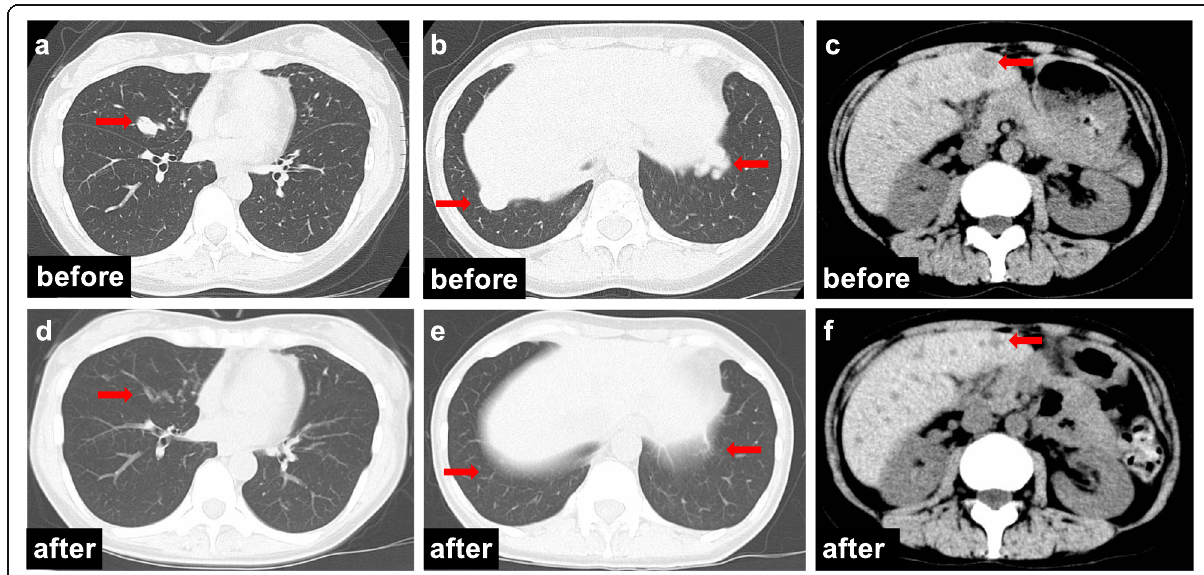
Fig. 4 Whole-body CT before and after chemotherapy. Lung metastatic nodules ( a , b ) and liver tumors ( c ) were detected. According to treatment with oral 5-FU, the lung metastatic tumors completely disappeared ( d , e ), and the liver metastases remarkably regressed ( f